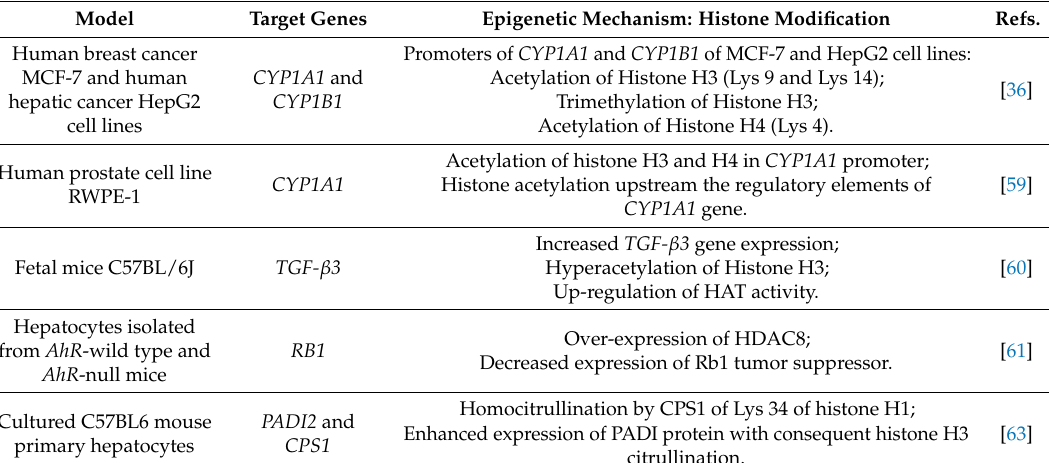
Table 2. Summary of the recent papers dealing with new insights in TCDD-induced epigenetic histone modifications of target